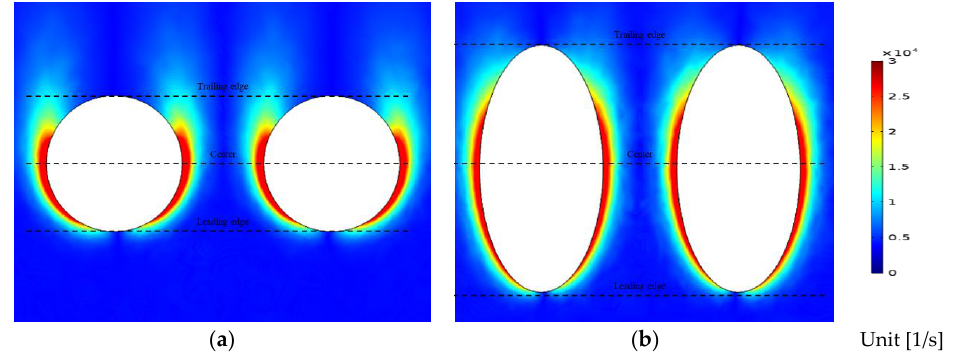
Figure 14. Vorticity contour around the obstacles: ( a ) Case 2 and ( b ) Case 8.